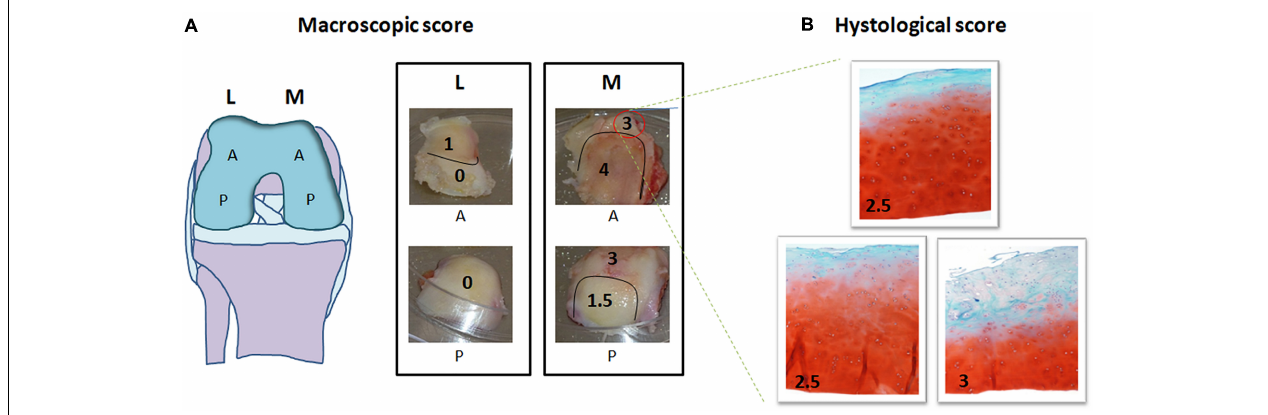
FIGURE 3 | Macroscopic and histological scoring of femoral condyles from a representative mono-compartmental knee OA patient. (A) Schematic drawing of the knee and images of the four condyle areas: femoral condyles (medial, M and lateral, L) removed by the surgeon were divided each in anterior (A) and posterior (P). Each of the four areas was scored by the surgeon based on macroscopic degeneration of the cartilage tissue by Collins grading system, thus obtaining further zoning. (B) For each zone identified, histological evaluation was performed in triplicate in three subareas. Macroscopic and histological scores attributed are indicated in each picture, histological images being at 10 × magnification.